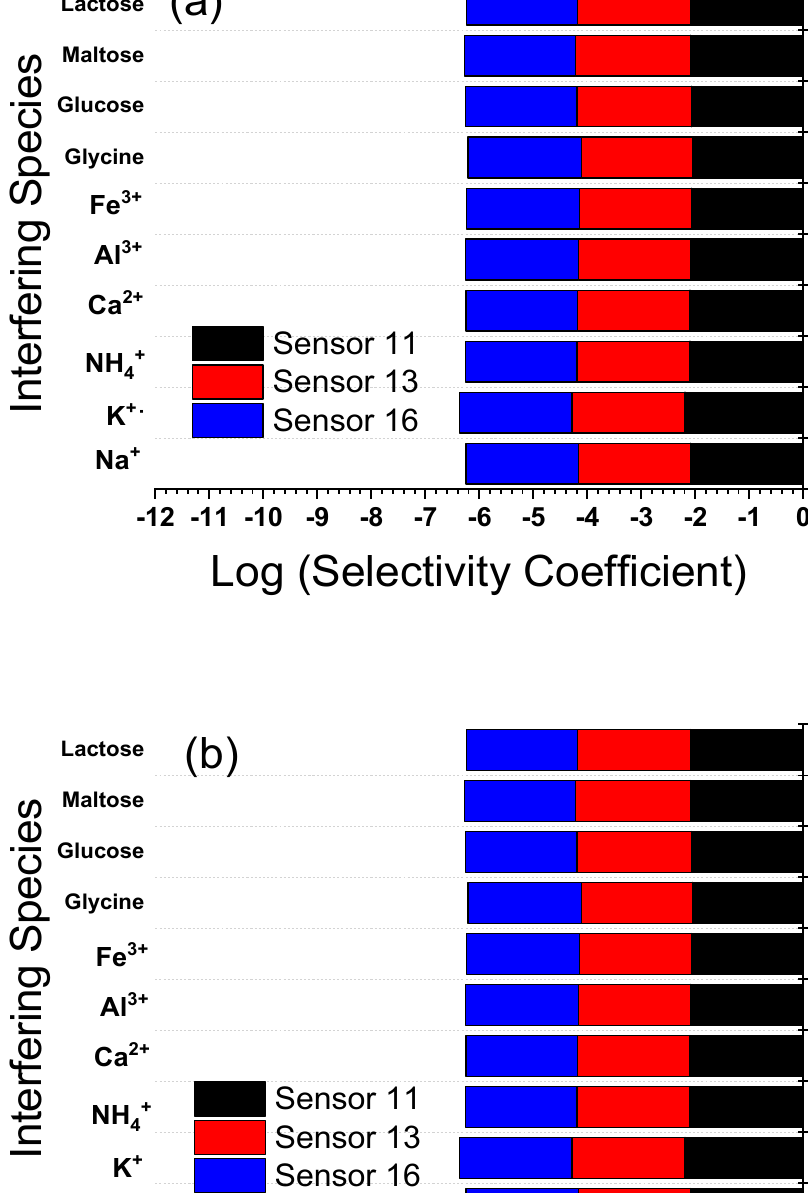
(cid:2926)(cid:2925)(cid:2930). , determined by using SSM and MPM for a carbon Figure 9. Log selectivity coefficient, log K (cid:2896)(cid:2890) (cid:3118)(cid:3126) ,(cid:2894) (cid:3126)(cid:3184) paste electrode (CPE, sensor 11); PVC membrane coated on a carbon paste electrode (C-CPE, sen- sor 13); PVC/CD plasticized carbon paste electrode (P-CPE, sensor 16) at room temperature of 22 ± 2 °C: ( a ) at pH 2.2; ( b ) at pH 4.1. The electrode compositions (%, wt / wt ) are given in (Table 1).